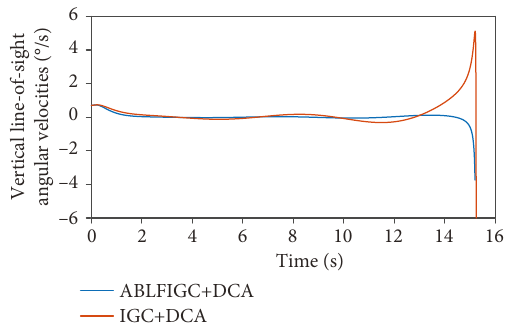
Figure 2: Curves of angular velocities of vertical line of sight of the interceptor missile in Scenario 1: ABLFIGC+DCA refers to a combination of the proposed asymmetric barrier Lyapunov function-based IGC algorithm and the dynamic control allocation algorithm; IGC+DCA refers to a combination of the IGC algorithm subject to the traditional dynamic surface sliding-mode control law and the dynamic control allocation algorithm.